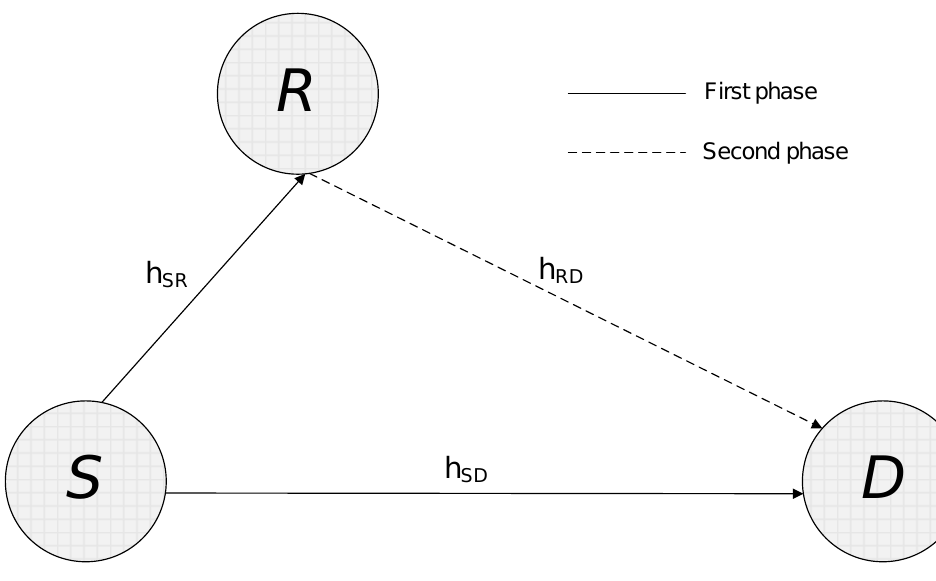
Figure 1. The three-terminal cooperative system under